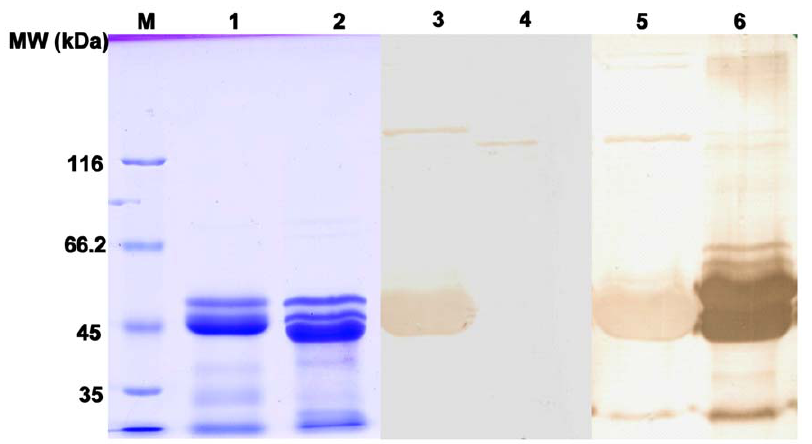
Figure 3. SDS-PAGE and Western Blot analysis of recombinant HX2 and HX1. SDS-PAGE analysis of purified rHX2 (lane 1) and rHX1 (lane 2) from the induced producer E. coli strains; Western blot analysis of rHX2 (lane 3) and rHX1 (lane 4) with hyperimmune sera against T15; Western blot analysis of rHX2 (lane 5) and rHX1 (Lane 6) with hyperimmune serum against HA9810; molecular size markers in kDa (Lane M).